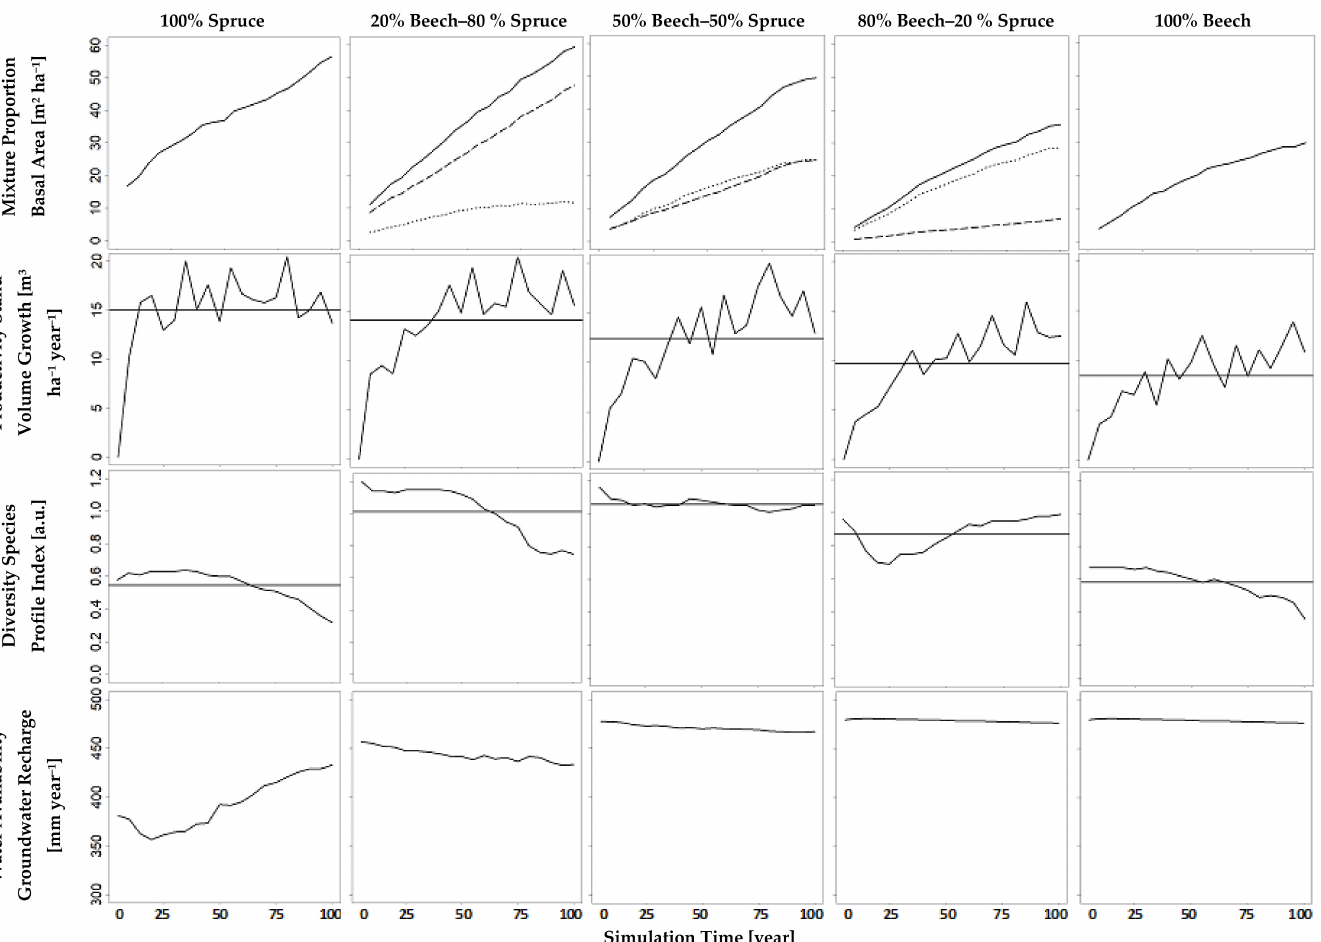
Figure 7. Influence of basal area composition on water availability, diversity and productivity based on simulation runs within a mixed stand of European beech and Norway spruce (Section 2.3); each column refers to exactly one run; that run presumed a relation of beech vs. spruce basal area as given by the column header; dotted line—beech, dashed line—spruce, horizontal line—average, solid line—total